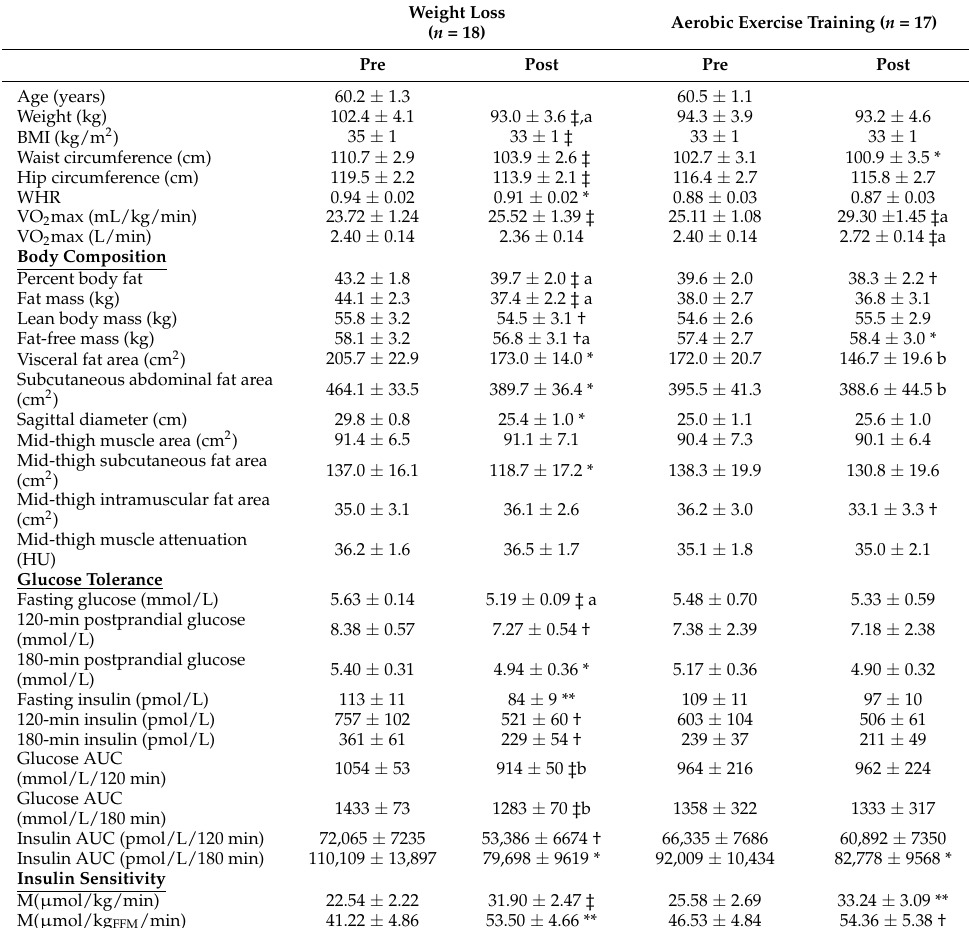
Table 1. Clinical and metabolic